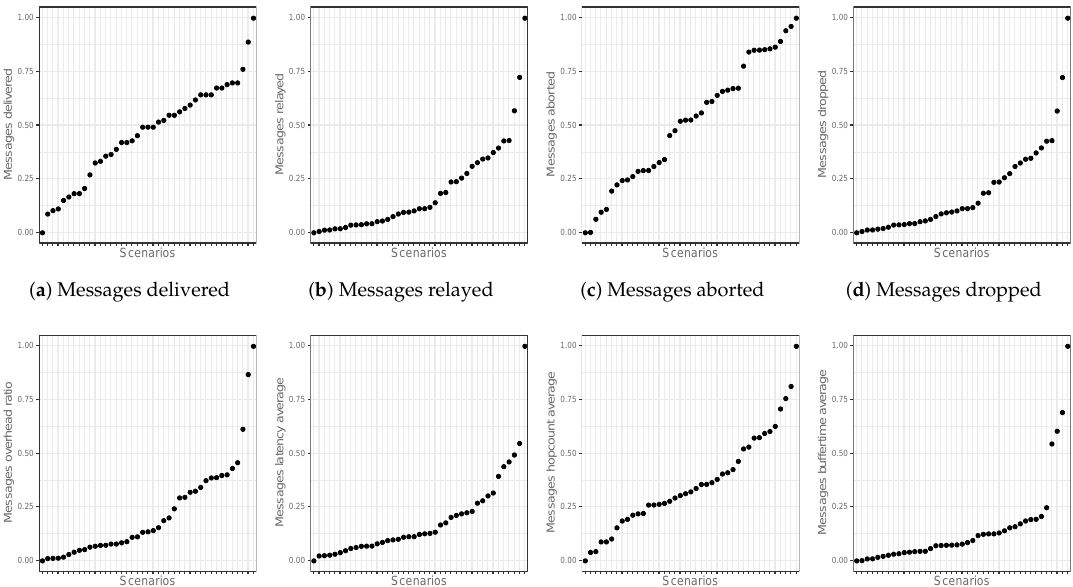
Figure 7. Corpus scaled benchmarks for epidemic routing. Each dot in the figure is a scaled outcome ordered by the the metric; the identification number of scenarios is not shown and the order changes among